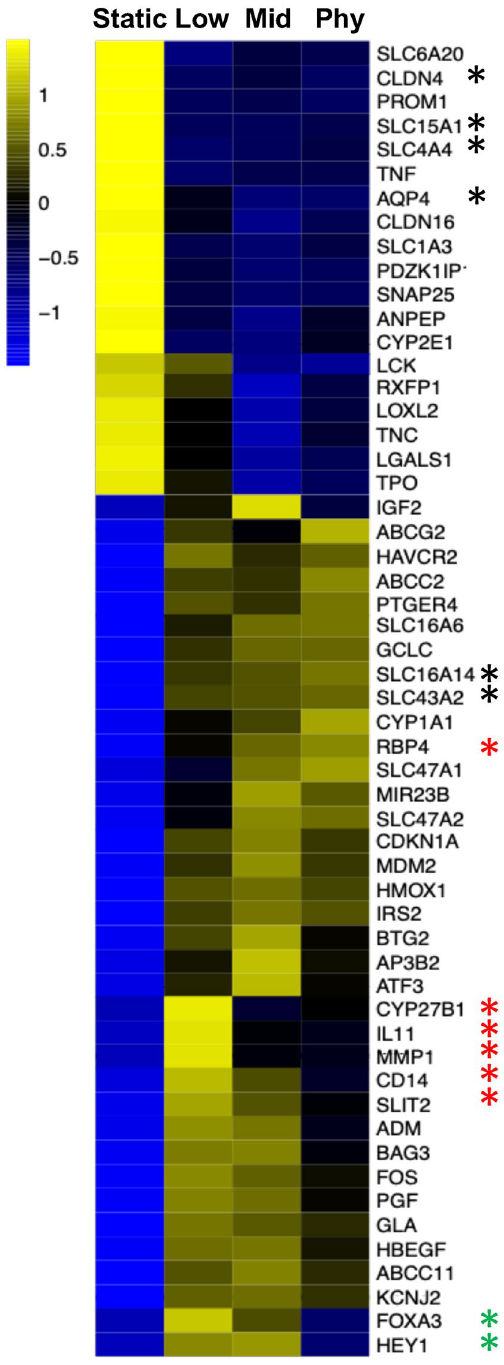
Figure 4. Proximal tubule cells under different fluidic shear stress alter expression of example genetic profiles. Statistically significant changes in expression of example genes associated with proximal tubule cells were identified by cross-comparisons of all four conditions (Low (0.1dyn/cm2), Mid (0.25dyn/cm2), Physiological (Phy) level (0.5dyn/cm2), and static baseline). Each column represents data from biological replicates at a specific experimental fluidic shear stress. Example genes were grouped by subtype or directionality. Replica count data for each gene were average across all corresponding samples and plotted as a heat map. More significant values are visualized in the yellow range and lower, less significant values, are visualized in